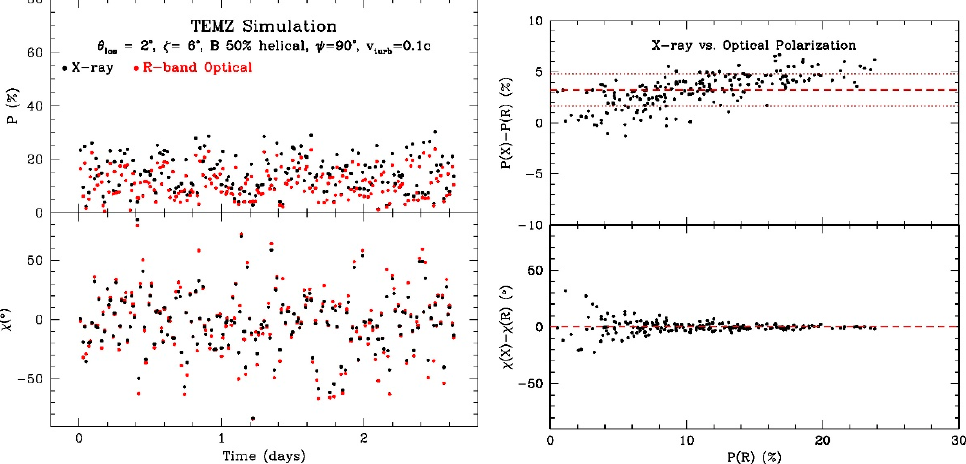
Figure 5. Simulated short time-scale variations of X-ray and optical linear polarization for parameters that roughly fit the SED and variability characteristics of Mkn421. The dashed red horizontal line in the upper right panel signifies the mean value of [ P (X) − P (R)], while the dotted lines demark ± 1 σ . The dashed line in the lower right panel demarks 𝜒(X) − 𝜒(R) = 0 .